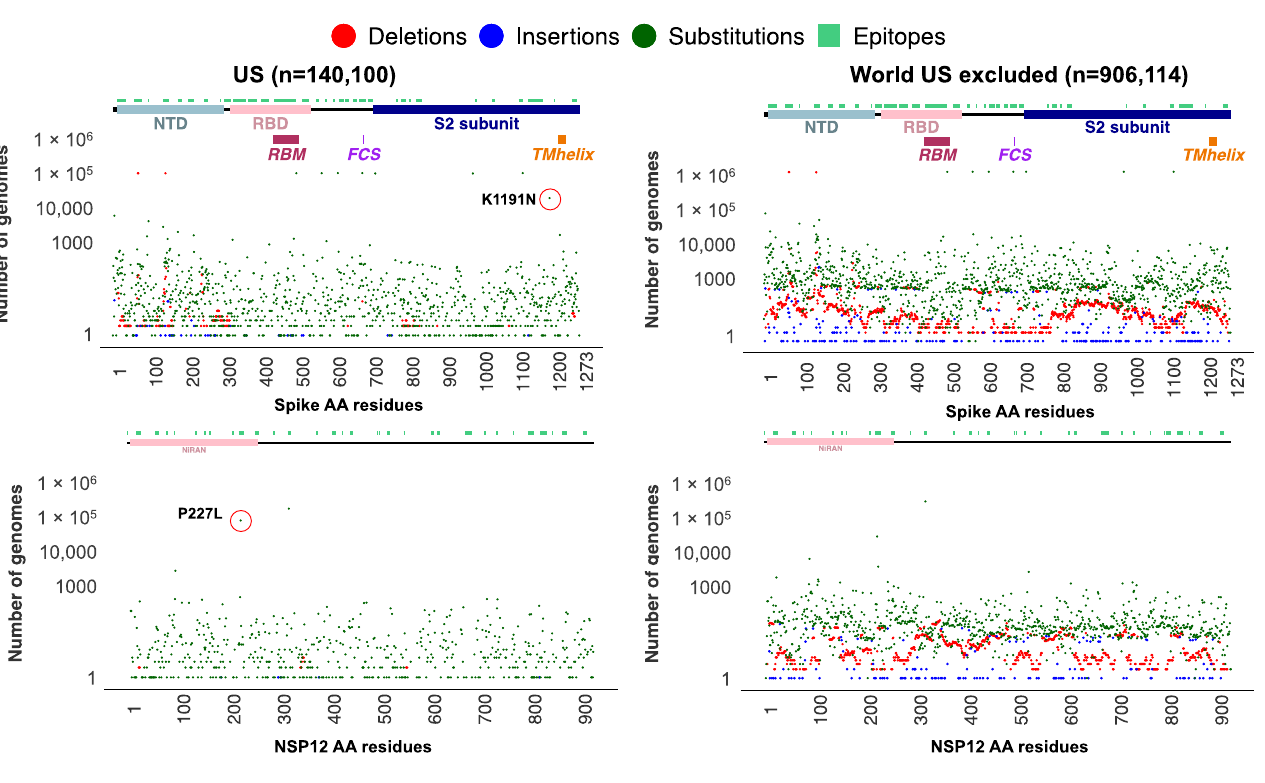
Figure 4. Absolute frequency of mutations in SARS-CoV-2 Spike and NSP12 among Alpha VOCs. SARS-CoV-2 genome data for all sequences assigned to an Alpha variant lineage (B.1.1.7 and Q.*) from the USA (n = 140,100) and rest of the world (n = 906,114, the USA cases excluded) were retrieved from GISAID as of 31 May 2022. Plots represent the absolute frequency of mutations at each amino acid position across Spike ( top ) and NSP12 ( bottom ) in sequences from the USA ( left ) and rest of the world ( right ). Deletions (red), insertions (blue), and substitutions (green) are plotted in different colors at each position. Boundaries for protein domains of Spike and NSP12 proteins were obtained from [16,17]. Predicted B-cell epitopes are highlighted above in teal, as predicted by [36]. Each subset of genomes was visualized separately using the ViralVar “Protein Distribution” feature.